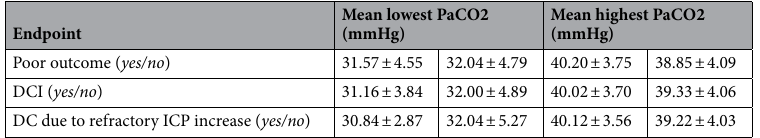
Table 1. Overview of lowest/highest mean PaCO2 value distribution among the different